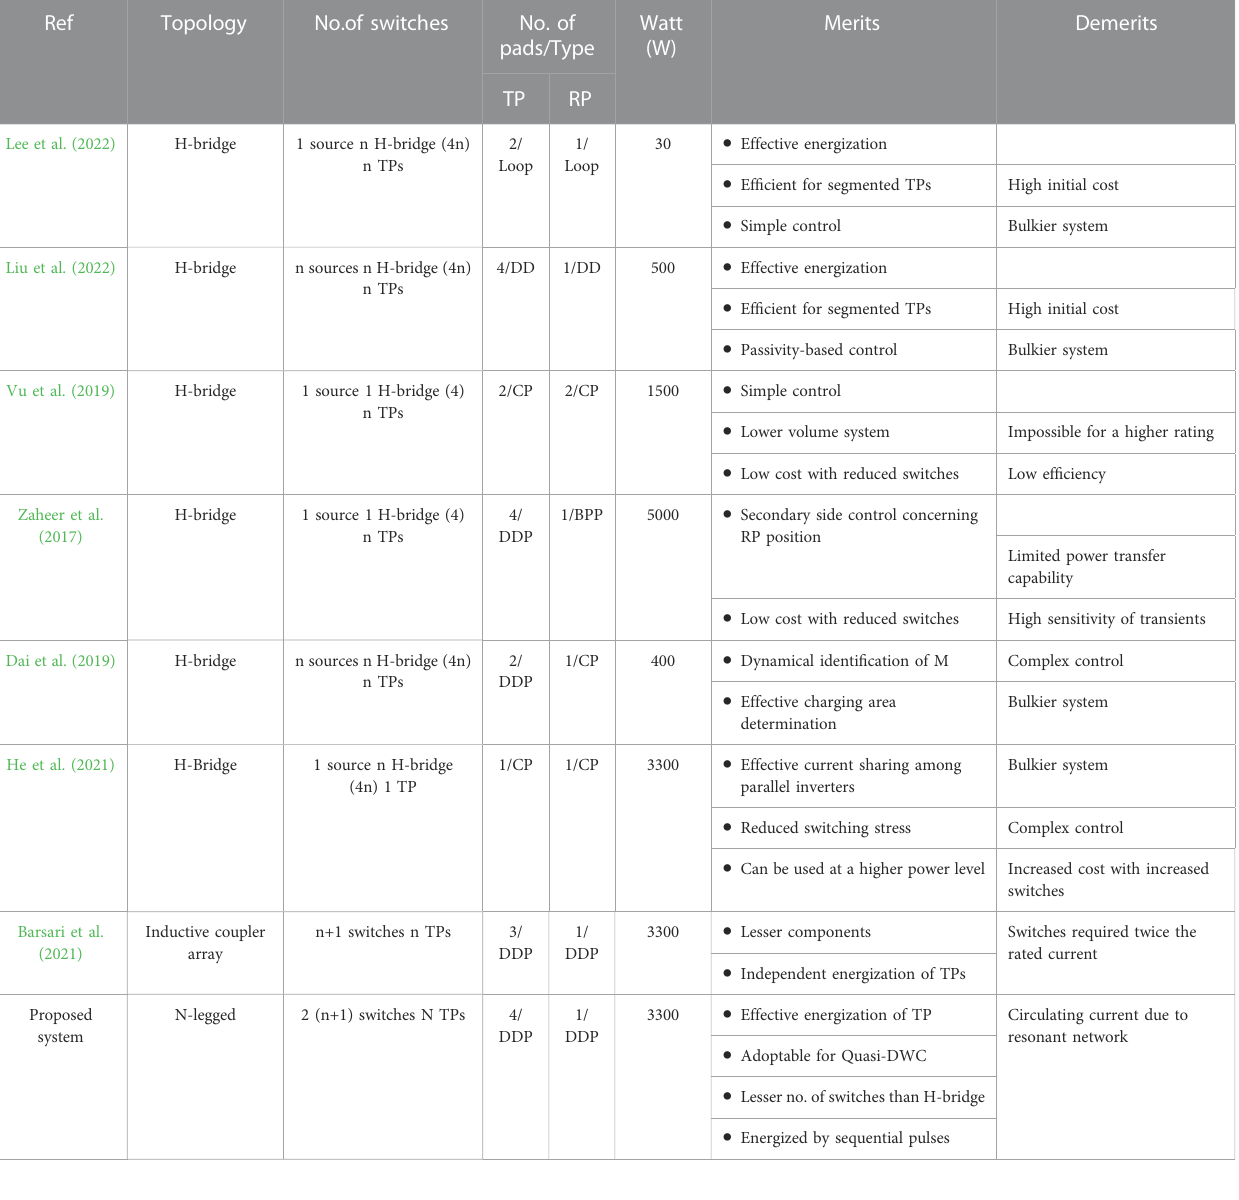
TABLE 1 Existing wireless charging inverter